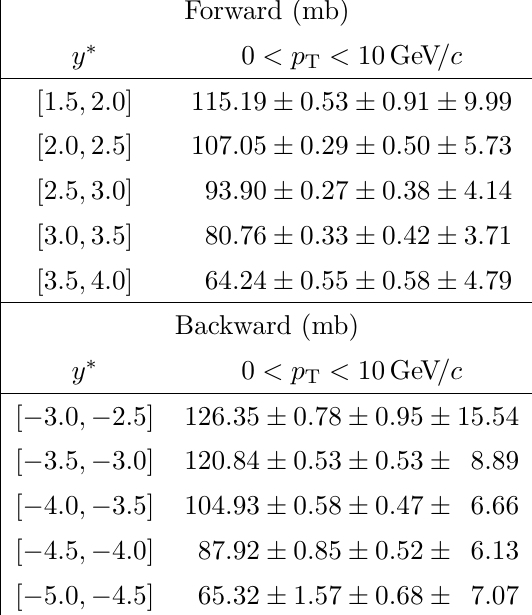
Table 4 . Di(cid:11)erential cross-section d (cid:27) (mb) for prompt D 0 meson production as a function of j y (cid:3) j d y (cid:3) in p Pb forward and backward data, respectively. The (cid:12)rst uncertainty is statistical, the second is the component of the systematic uncertainty that is uncorrelated between bins and the third is the correlated